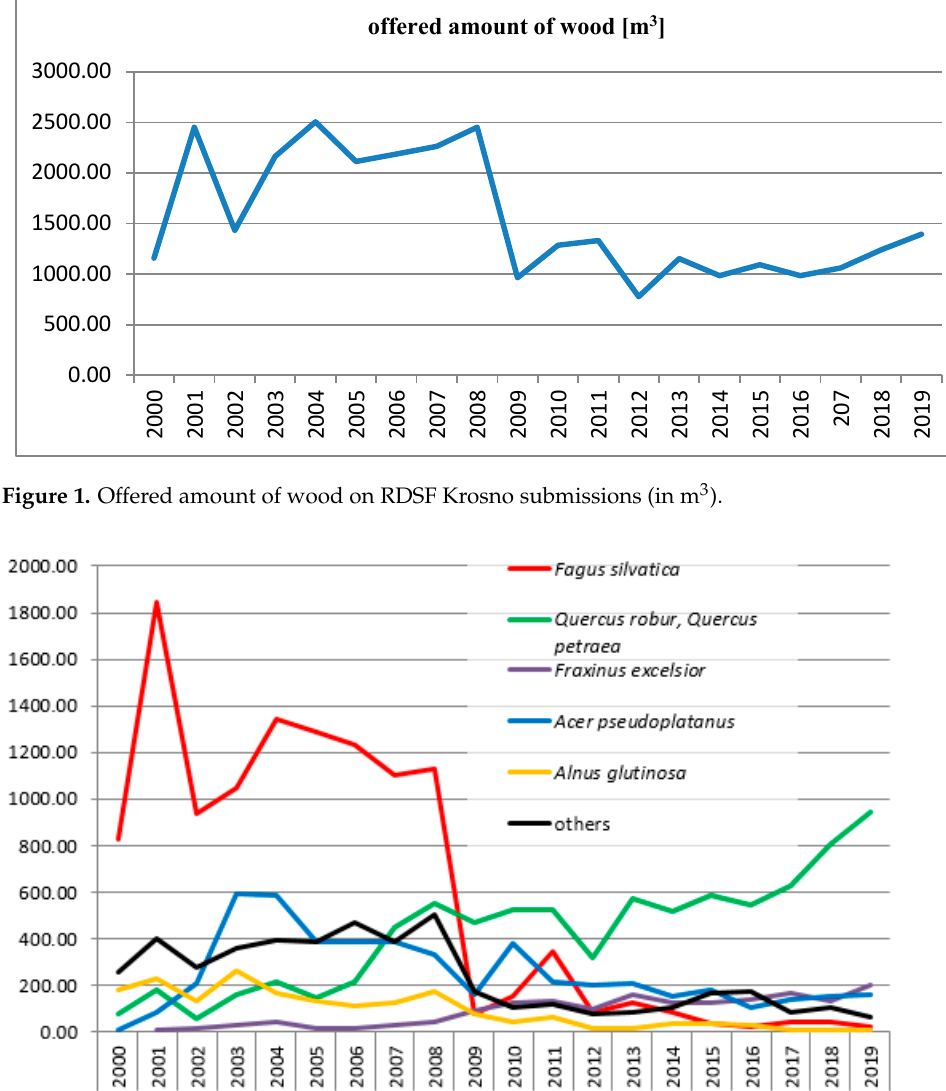
Figure 2. Annual changes of amount of offered wood by species (in m 3 ).